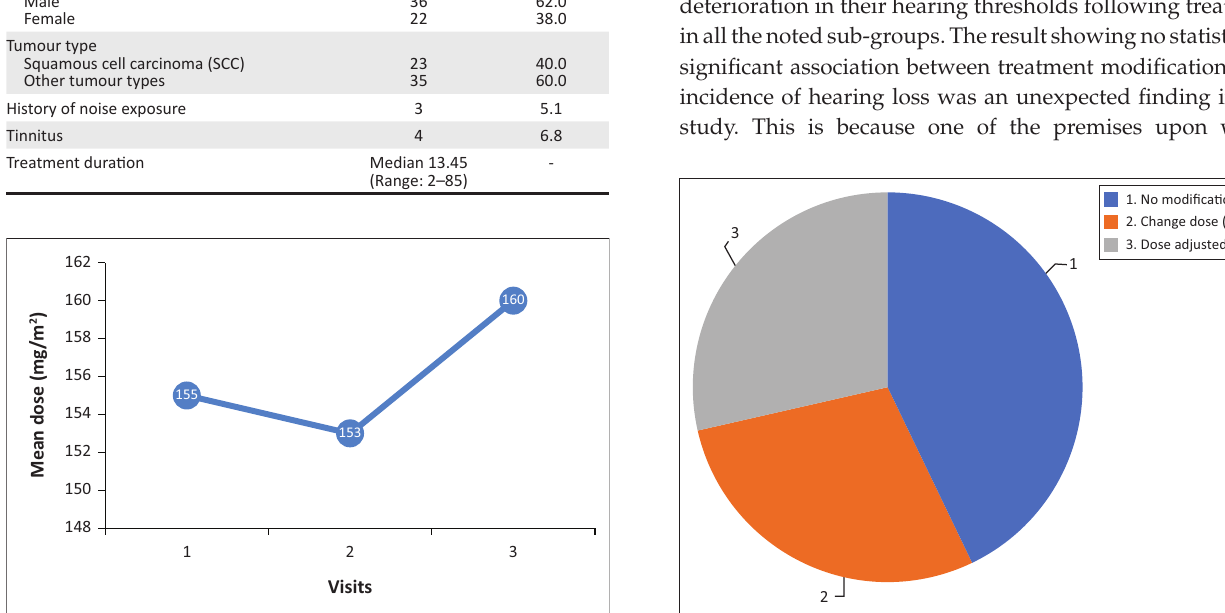
FIGURE 1: Median single cisplatin dose at different visits ( n = 58). TABLE 2: Ototoxicity and severity of hearing loss by treatment modification at the end of treatment. Grading system